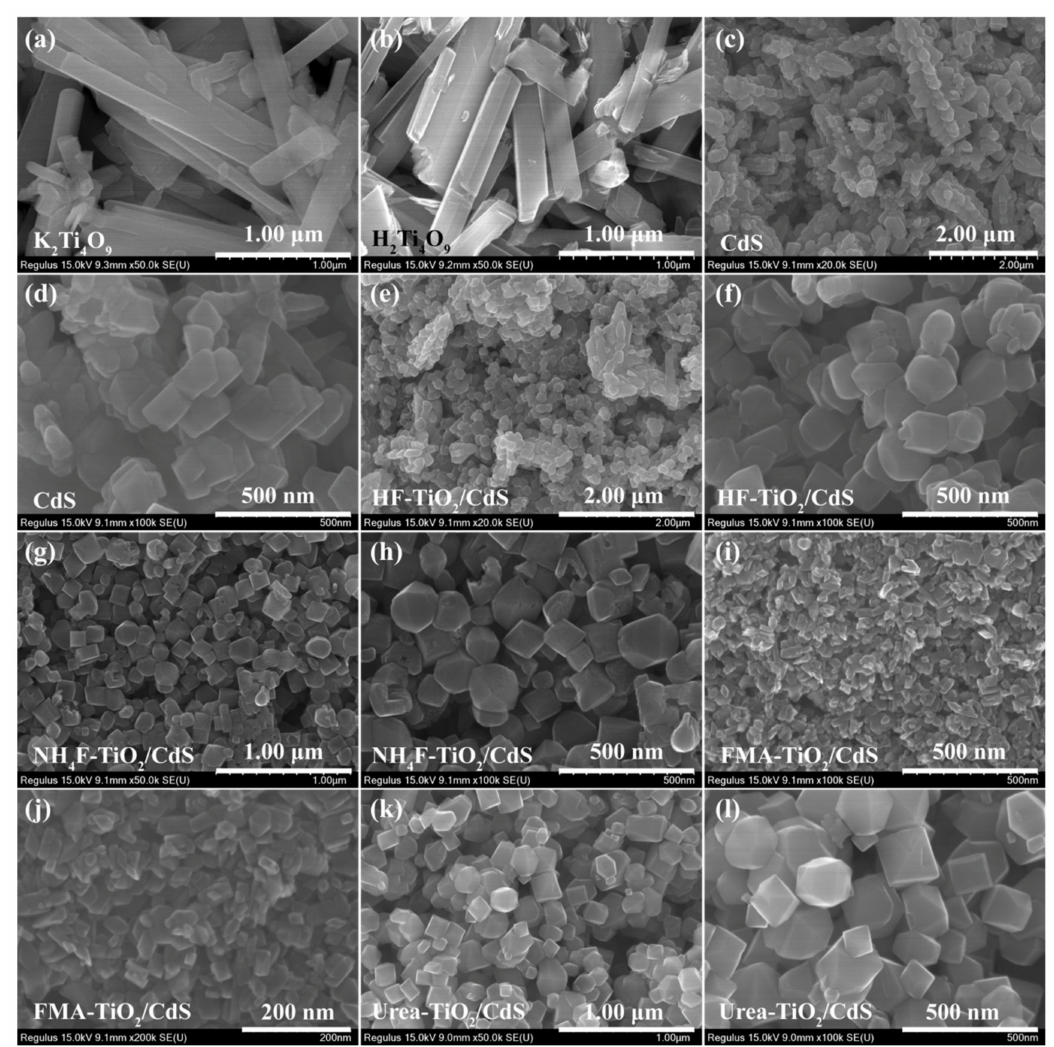
Figure 3. FESEM images of ( a ) K 2 Ti 4 O 9 , ( b ) H 2 Ti 4 O 9 , ( c , d ) CdS, ( e , f ) HF-TiO 2 /CdS, ( g , h ) NH 4 F-TiO 2 /CdS, ( i , j ) FMA- TiO 2 /CdS, and ( k , l ) Urea-TiO 2 /CdS